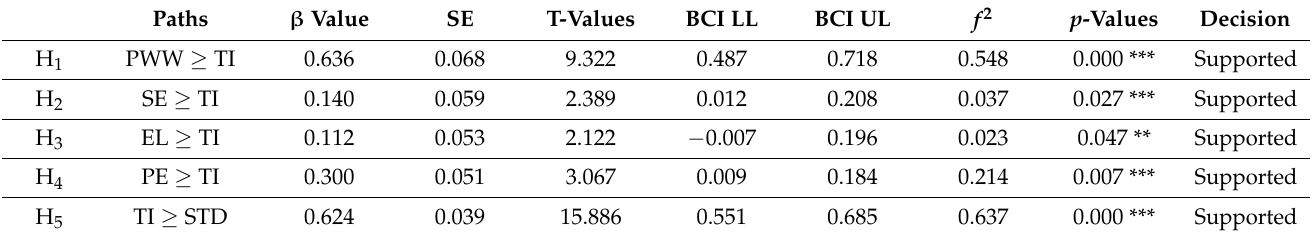
Table 5. Hypotheses